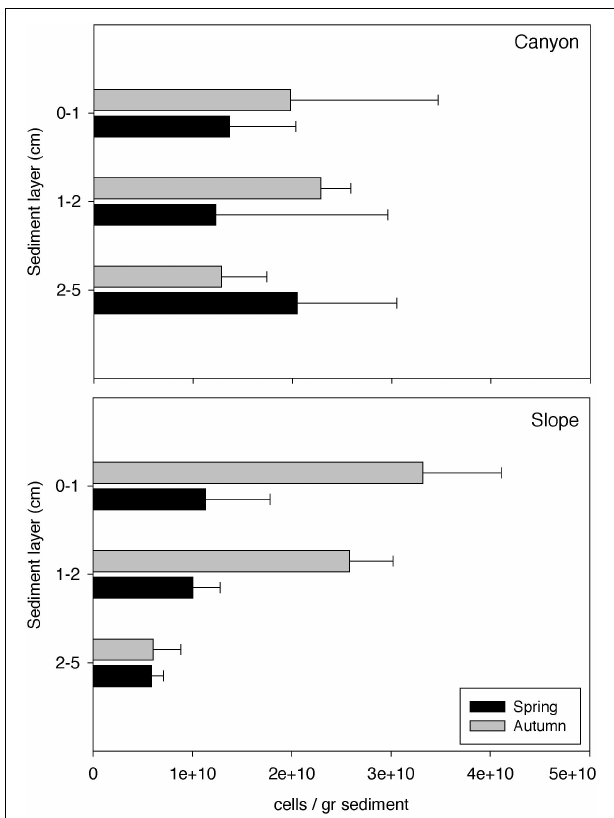
FIGURE 5 | Estimated microbial abundances (number of cells/gram of sediment) along the vertical sediment profile in the canyon and on the slope during autumn and spring. Errors bars are standard deviations.